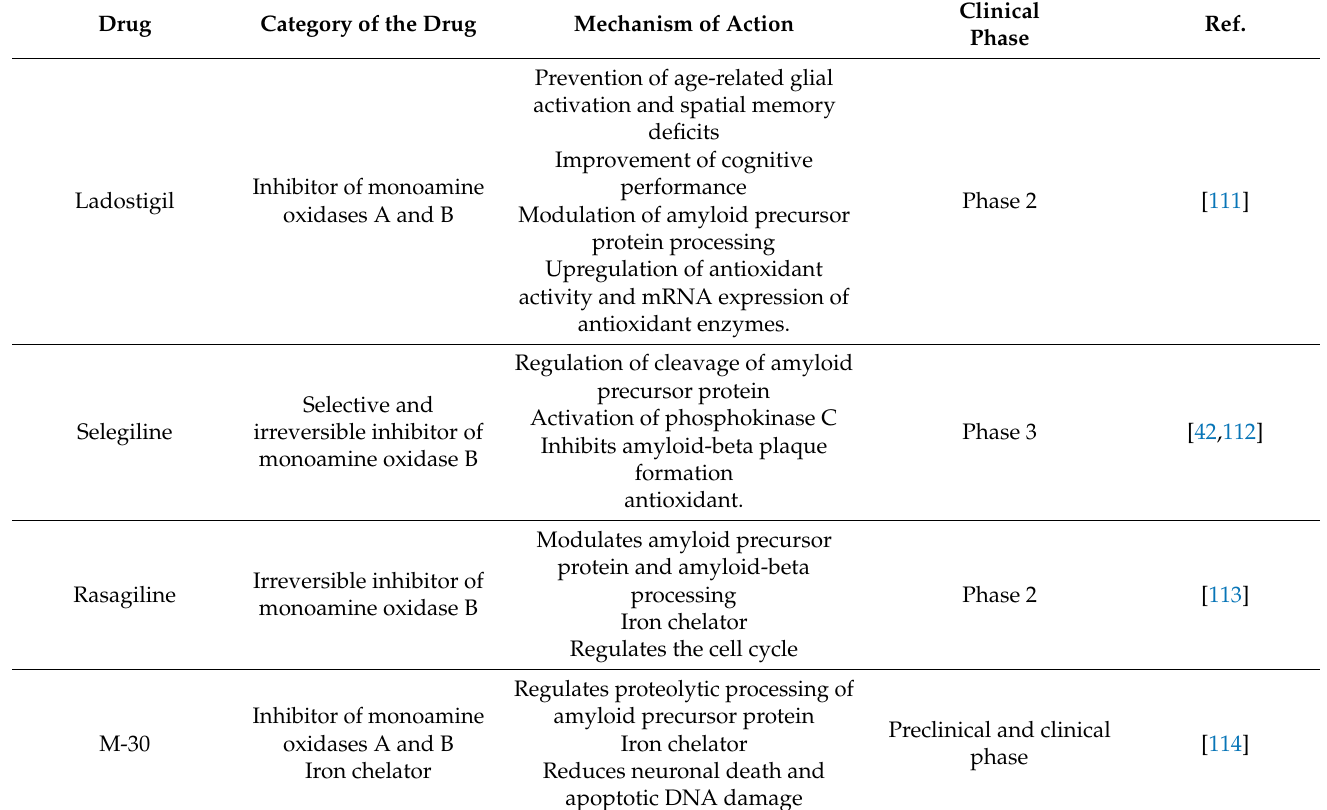
Table 2. Monoamine oxidase inhibitors in the preclinical trials for the treatment of Alzheimer’s disease. Drug Category of the Drug Mechanism of Action